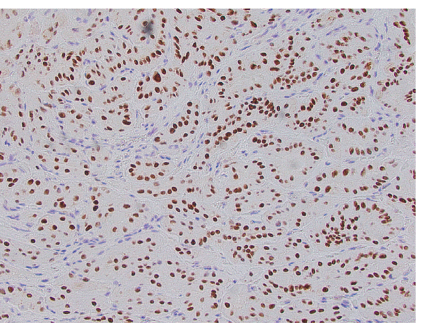
Figure 5: Positive nuclear staining with TTF-1 immunostain confirming the thyroid